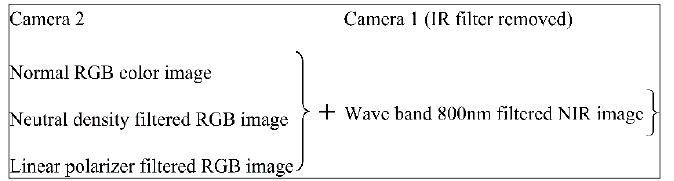
Figure 2. Combination of citrus fruit image acquisition.